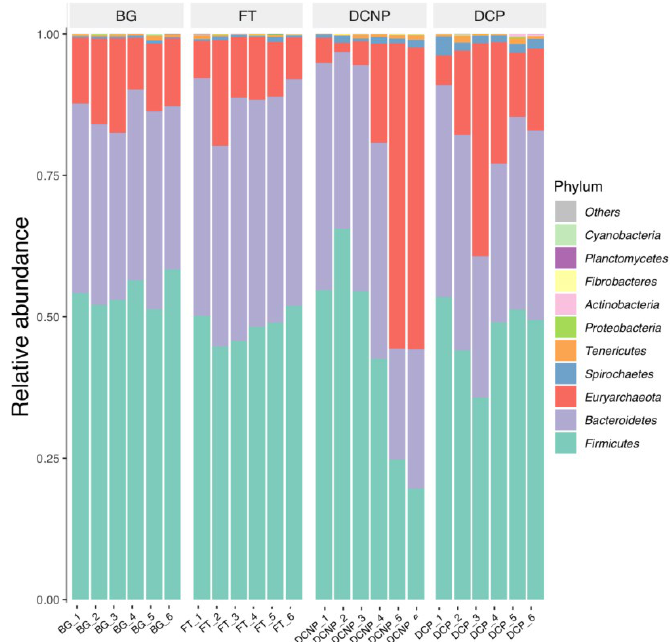
Figure 3. Relative abundance of fecal microbiota at the phylum level in the four groups.